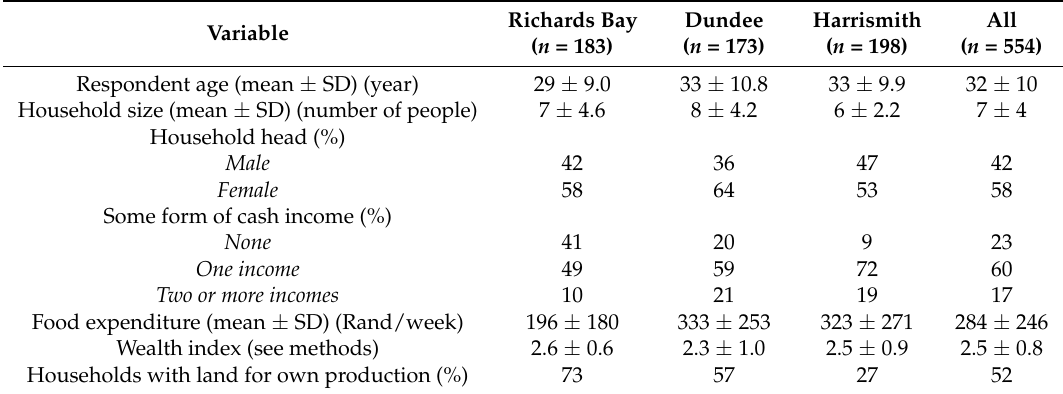
Table 1. Comparison of household characteristics in study